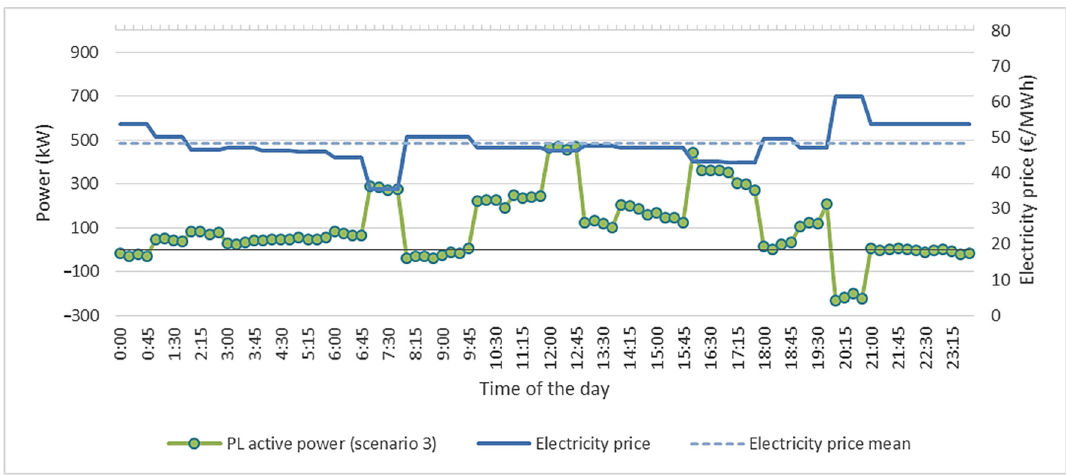
Figure 9. PL’s active power in scenario 2 and electricity price.